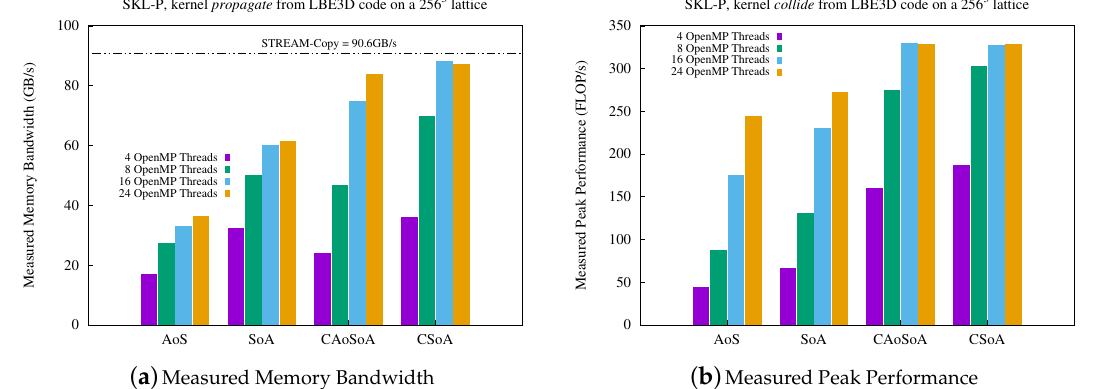
Figure 3. ( a ) measured memory bandwidth for the propagate kernel, ( b ) the measured peak performance for the collide kernel, for the SKL-P processor. The performance measurement is reported using a single MPI process on the socket and a number of threads equal to the maximum number of cores available on the given CPU model. Results are from a simulation with 256 3 lattice sites representing a real